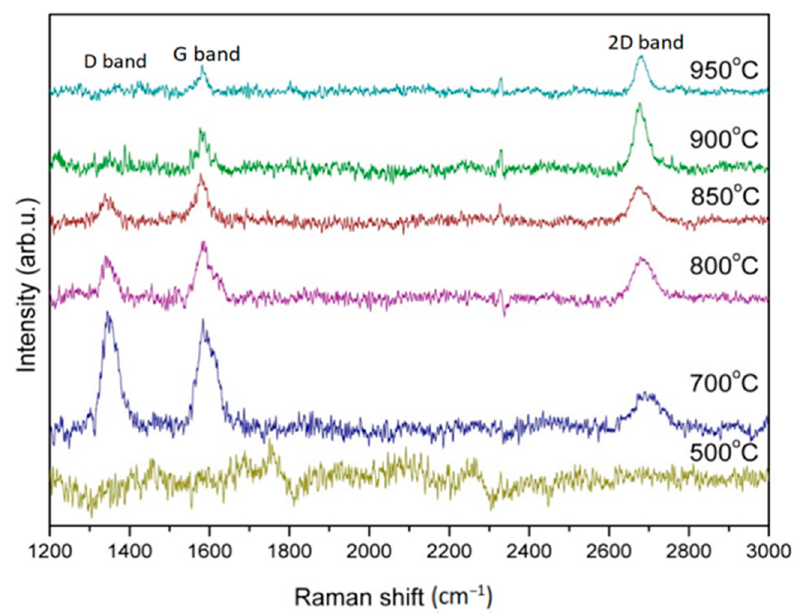
Figure 2. Raman patterns of graphene grown on copper foil substrate with 20 sccm Ar carrying methanol and 15 sccm H 2 in the time period of 30 min at growth temperatures of 500 °C, 700 °C, 800 °C, 850 °C, 900 °C, 950 °C, respectively.